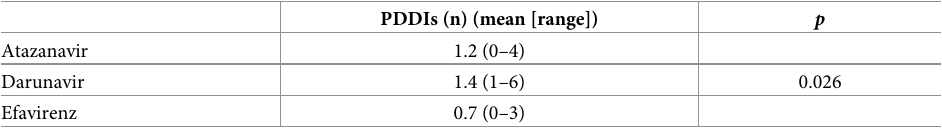
Table 2. Potential drug-drug interactions.